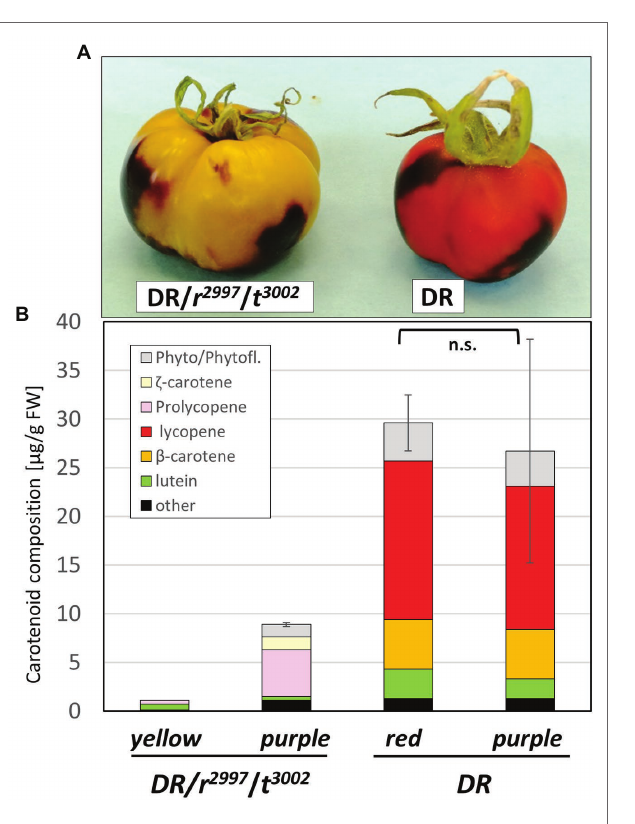
FIGURE 6 | Transient silencing of PSY2 in fruits of the double mutant r 2997 / t 3002 . TRV-based silencing of PSY2 was done in the Moneymaker line expressing the Delila Rosea (DR) and in a triple mutant DR, yellow flesh and tangerine (DR/ r 2997 / t 3002 ). (A) Phenotype of fruit sector after co-silencing by VIGS of the Del/Ros1 ( DR ) and the PSY2 genes. (B) Carotenoid composition ( μ g g − 1 FW) in different fruit sectors. The sectors were dissected from the silenced (yellow) and non-silenced (purple) of the quadruple mutant DR / r 2997 / t 3002 , and the silenced (red) and non-silenced (purple) of the DR plants as a control (right). The data were compared using the “Compare all pairs” (Tukey–Kramer), p < 0.05. n.s., no